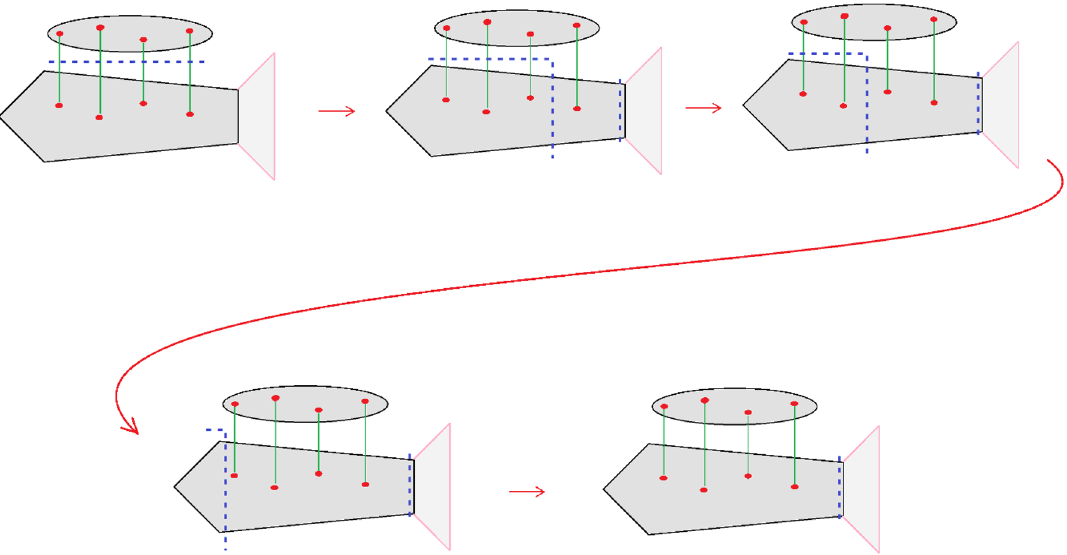
Figure 16 . At late times, a more e(cid:14)cient way of sweeping between the two minimal cuts is to create two cuts near the horizon, and then to sweep one of these cuts \backwards" along the